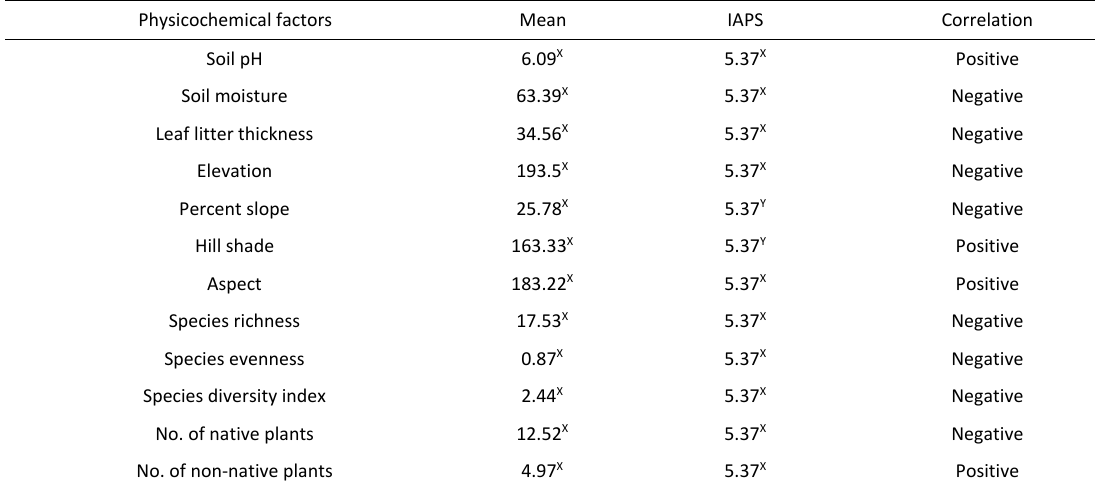
Table 2 : Association between the Physicochemical Factors to the Presence of IAPS Table 2: Association between the Physicochemical Factors to the Presence of Physicochemical factors